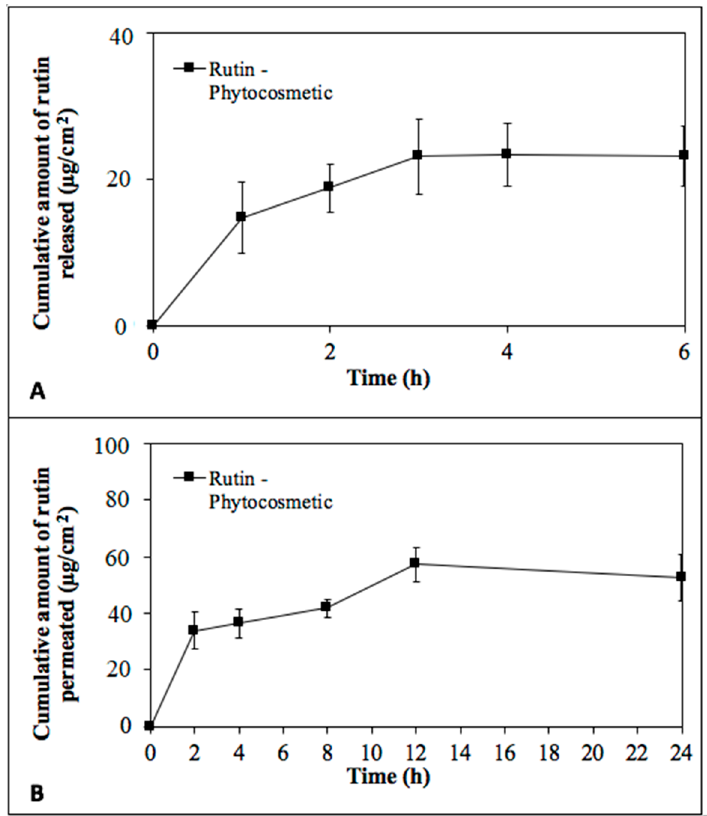
Figure 4. Rutin concentration of µg/mL from phytocosmetic by release test ( A ) and by permeation test ( B ).